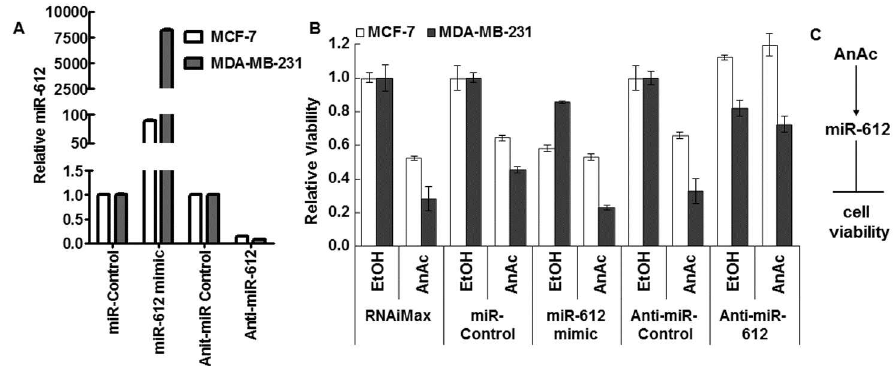
Fig 4. Overexpression of miR-612inhibits cell viability and inhibition of miR-612inhibits AnAc’s anti- proliferative activity. MCF-7 and MDA-MB-231 cells were transfected with miR-Control (negativecontrol), miR-612mimic, anti-miR-Control (negativecontrol), or anti-miR-612 for 24 h prior to 48 h treatment with EtOH (vehiclecontrol) or 13.5 μ M (MCF-7) or 35 μ M (MDA-MB-231) AnAc. miR-612expressionwas measuredby qPCR relativeto RNU48in the transfected, untreatedcells 72 h after transfectionto match the time of the MTT assay (B). Values are the averageof triplicate determinations ± SEM in one transfectionand are relative to the appropriate transfectioncontrol as indicated. Cell viability was evaluatedby MTT assay (B). Values for the MTT assay are relativeto negative controls and are the avg ± SEM of 2 separate experiments. AnAc is proposed to affect cell viabilitythrough